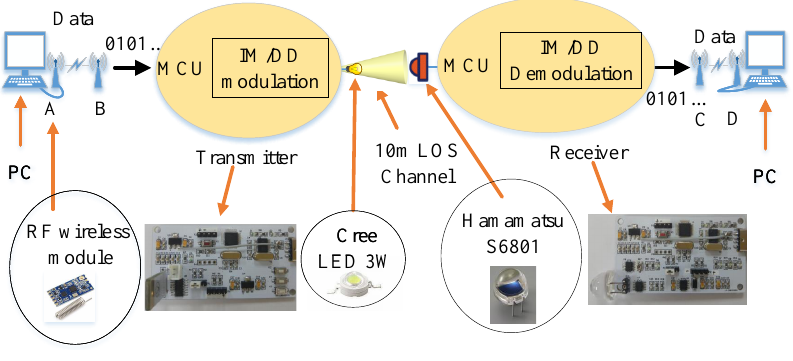
Figure 4. Transceiver